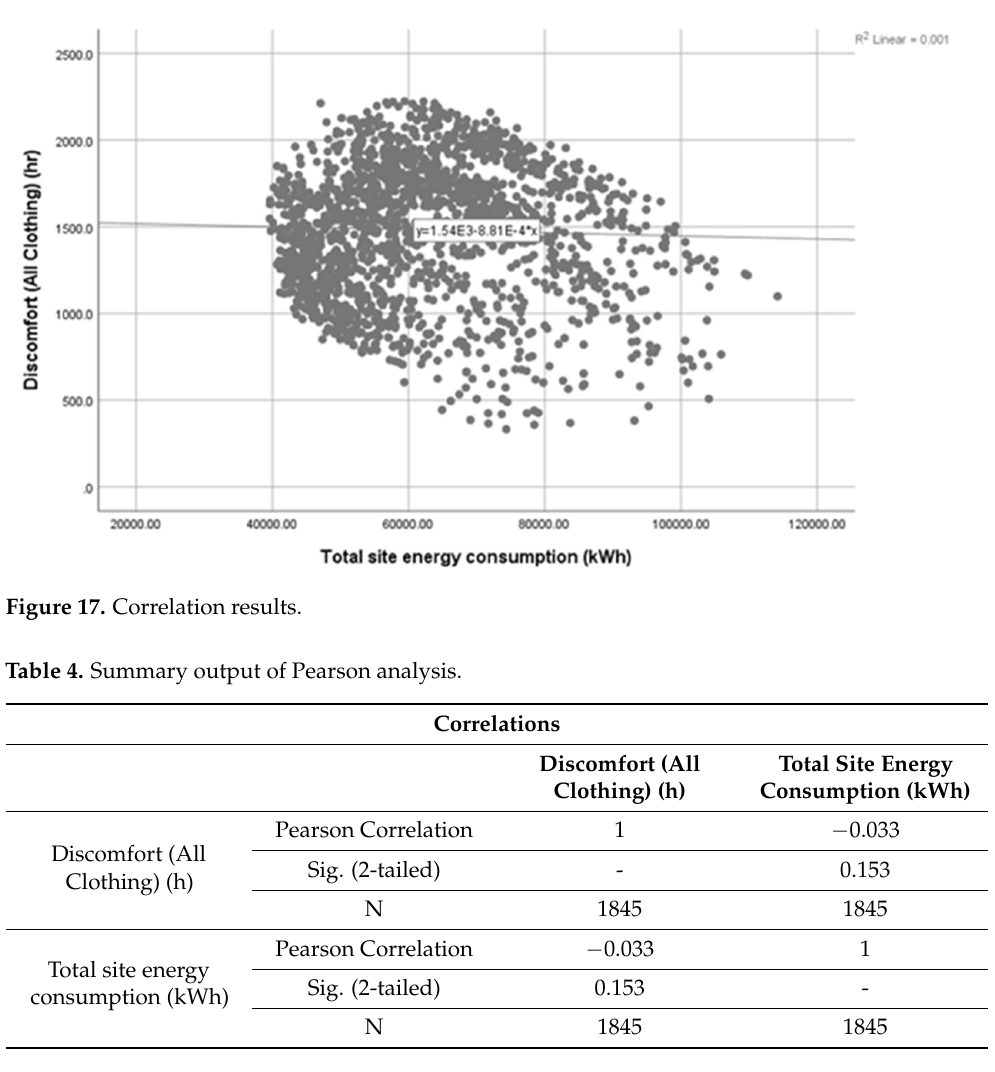
Figure 18. Cluster specification for each group .